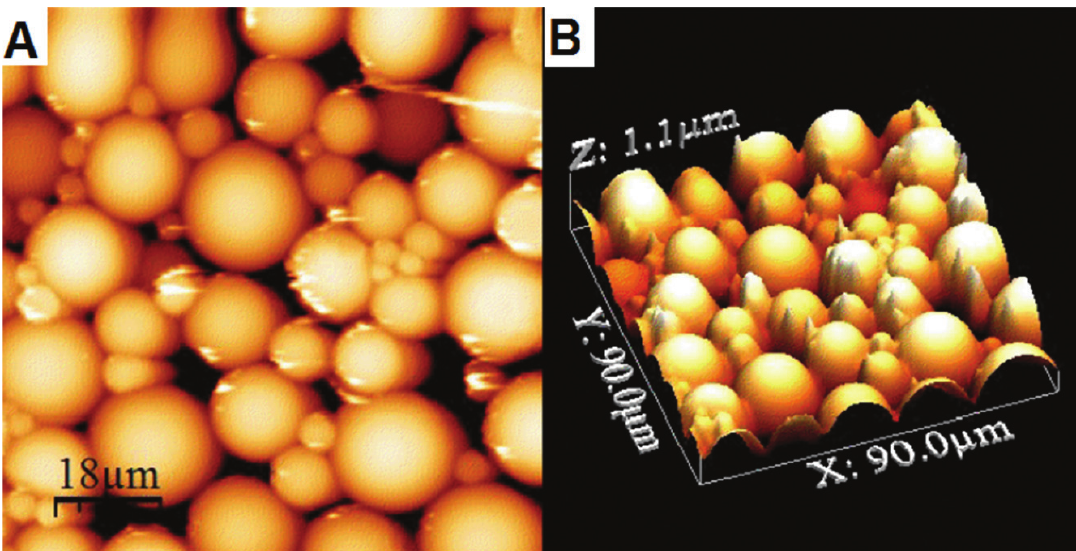
Figure 4. Two-dimensional (A) and three-dimensional (B) atomic force microscopy images of PLDLA microspheres containing paclitaxel at ambient conditions.